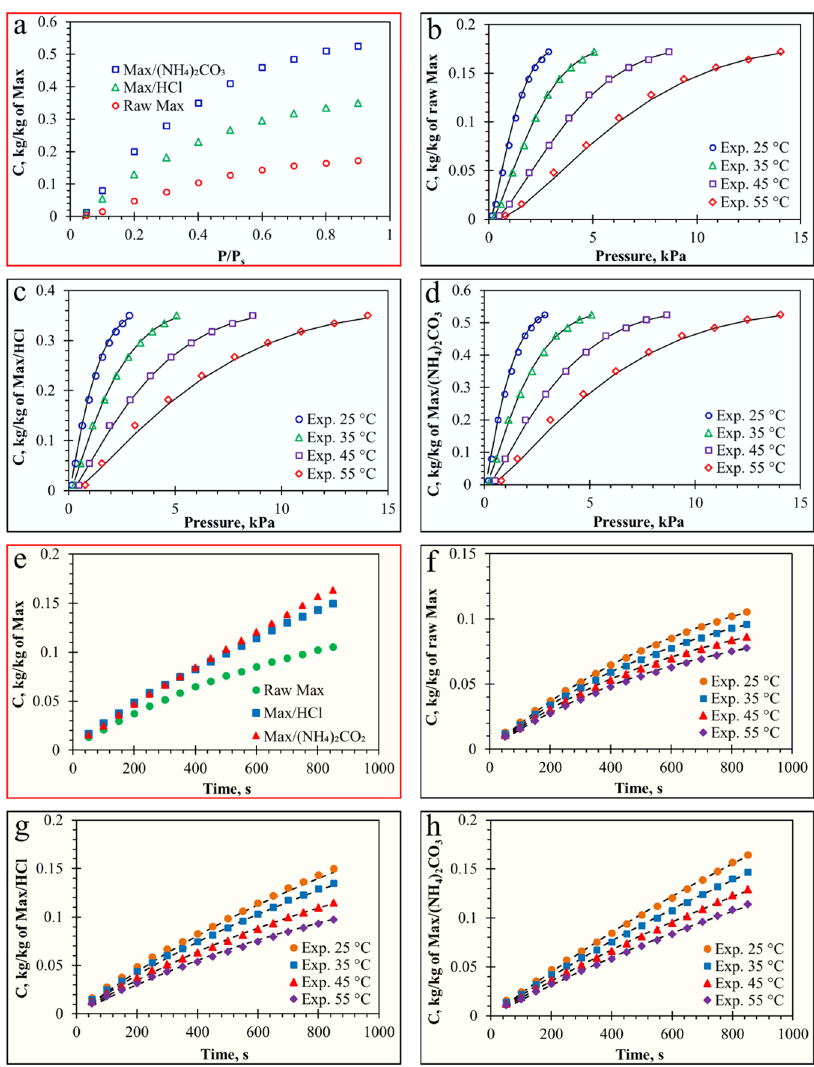
Fig. 3 Water equilibrium analysis for Max samples. a Max samples Ad-Iso at 25 °C, b raw Max Ad-Iso, c Max/HCl Ad-Iso, d Max/(NH 4 ) 2 CO 3 Ad- Iso, e Max samples Ad-Kin at P/P s = 0.9 and Ad-T = 25 °C, f raw Max Ad-Kin, g Max/HCl Ad-Kin, and h Max/(NH 4 ) 2 CO 3 Ad-Kin. Max/(NH 4 ) 2 CO 3 displays the highest water Ad-C for isotherms and kinetics